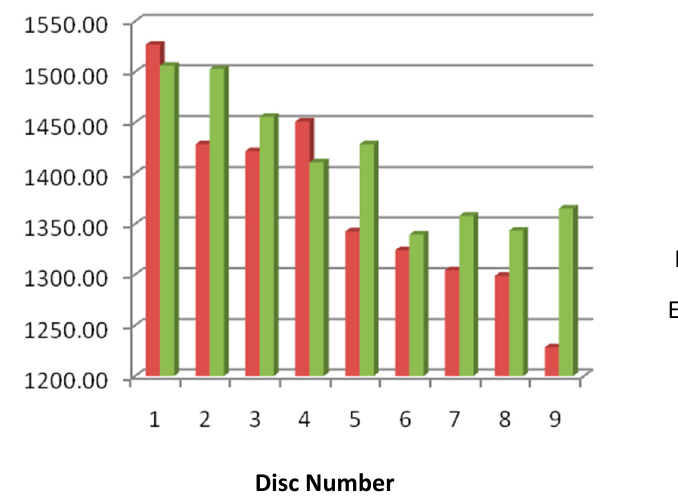
Figure 8. Comparison of finite element model with experimental results.